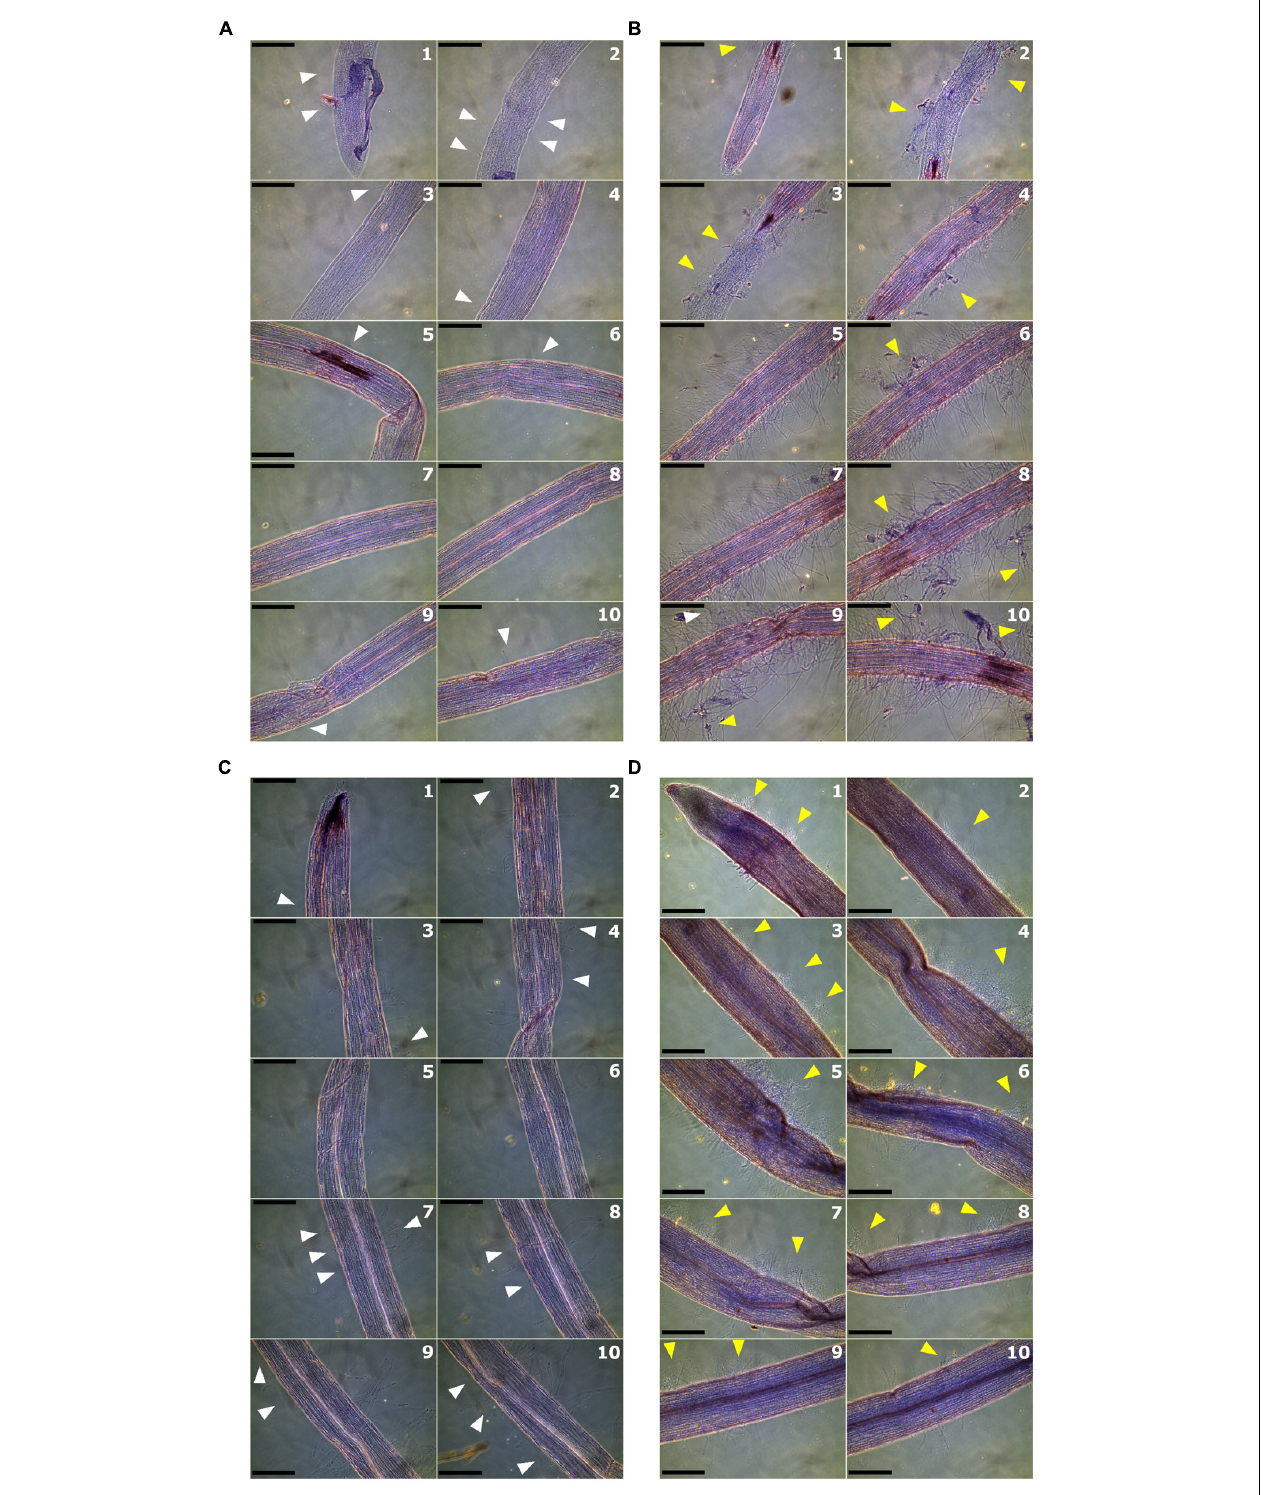
FIGURE 4 | Root colonization by Fusarium oxysporum f. sp. lycopersici ( Fol ) race 3 observed by phase-contrast microscopy at 24 h after inoculation. Roots were scanned at 10 overlapping zones starting from root tips and moving toward the crown. Numbers in each panel denote the sequential root zones. Light or mild colonization is shown by white arrows whereas heavy colonization is shown by yellow arrows. (A) Colonization of roots of 76R; (B) root colonization in rmc ; (C) root colonization in 26AK02, a putative complemented rmc ; and (D) root colonization in CRISPR01, a putative knock-out 76R. Scale bars = 200 µ m.